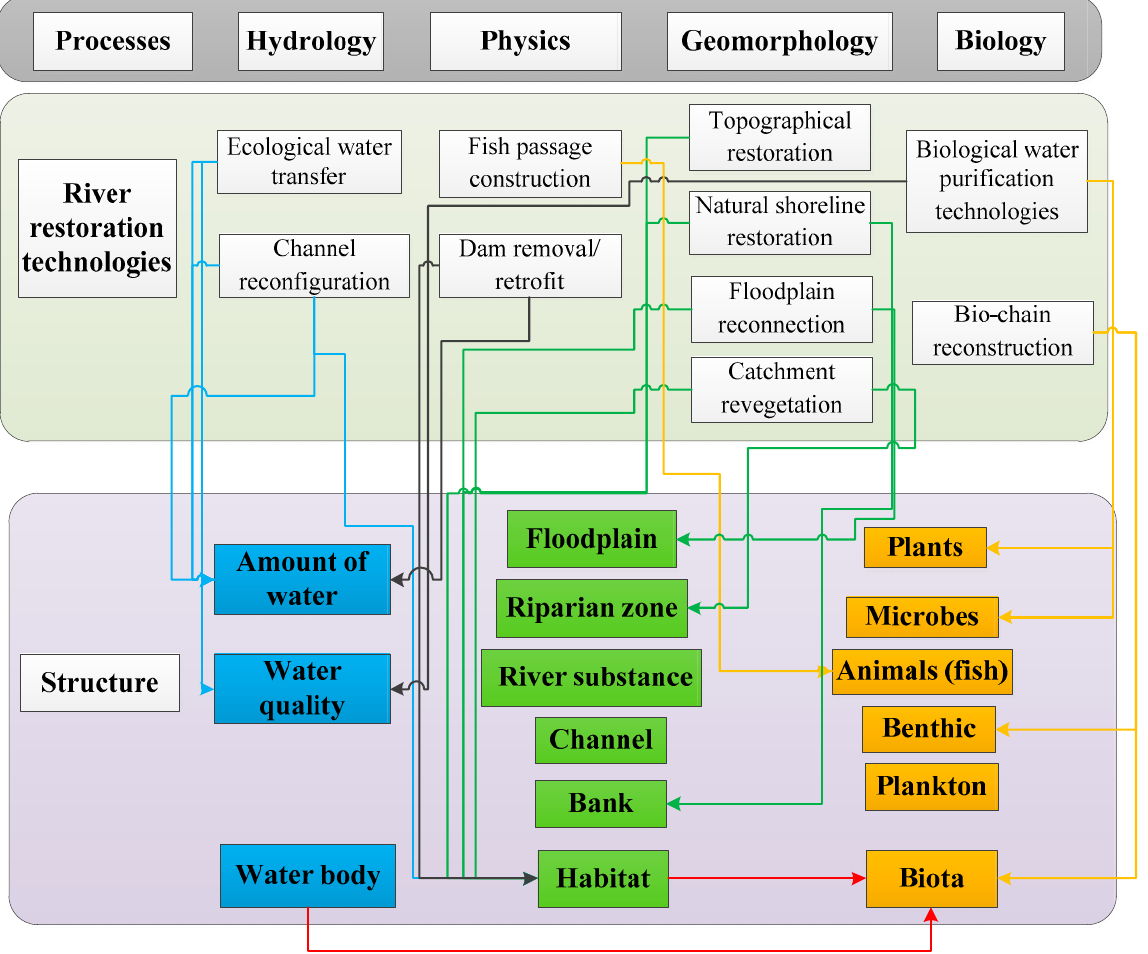
Figure 2. The classification of different restoration technologies.